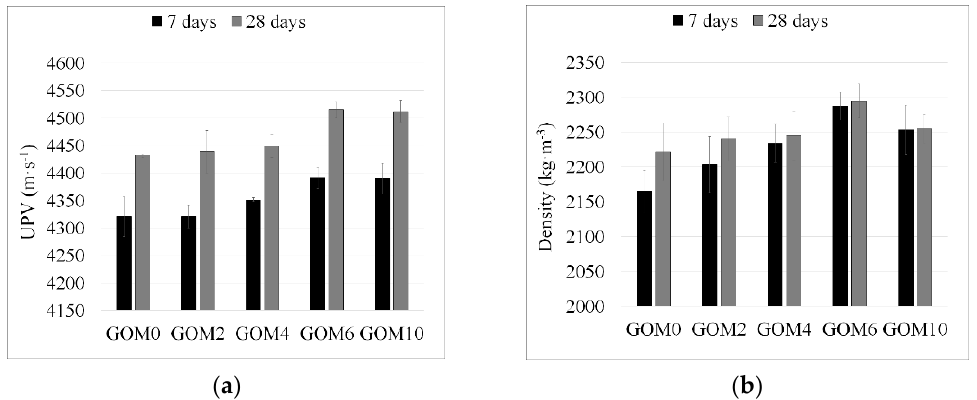
Figure 9. Dry bulk density ( a ) and UPV ( b ) of mortars cured for 7 and 28 days, respectively.